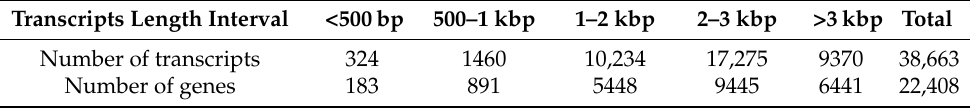
Figure 1. Statistical results of consensus reads’ distribution. The horizontal axis represents length of read and the vertical axis the read number. Table 3. Statistical results of length frequency distribution before and after transcript